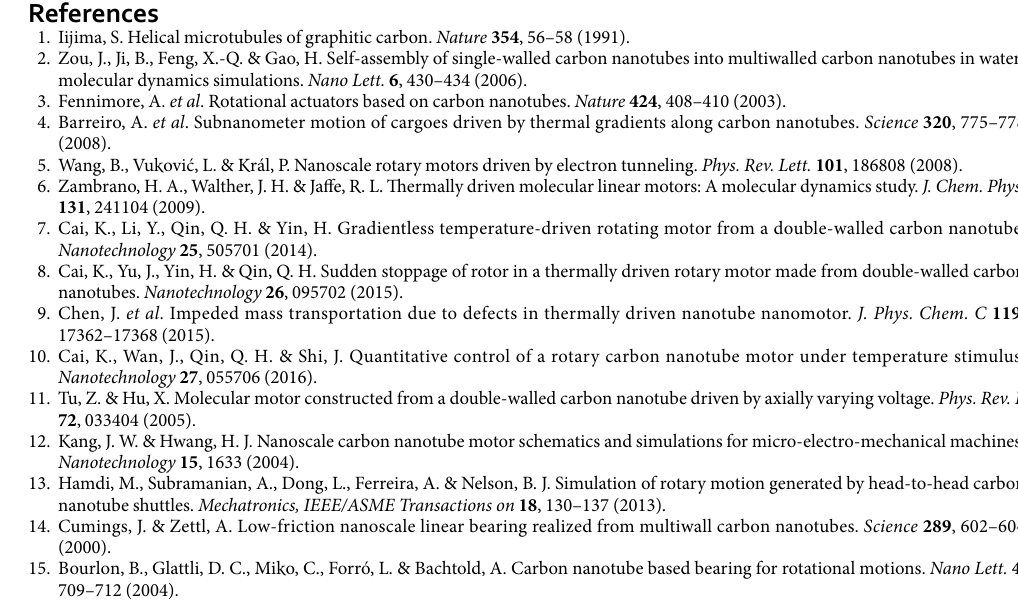
6 Scientific REPORTS | 7: 6772 | DOI:10.1038/s41598-017-07184-x